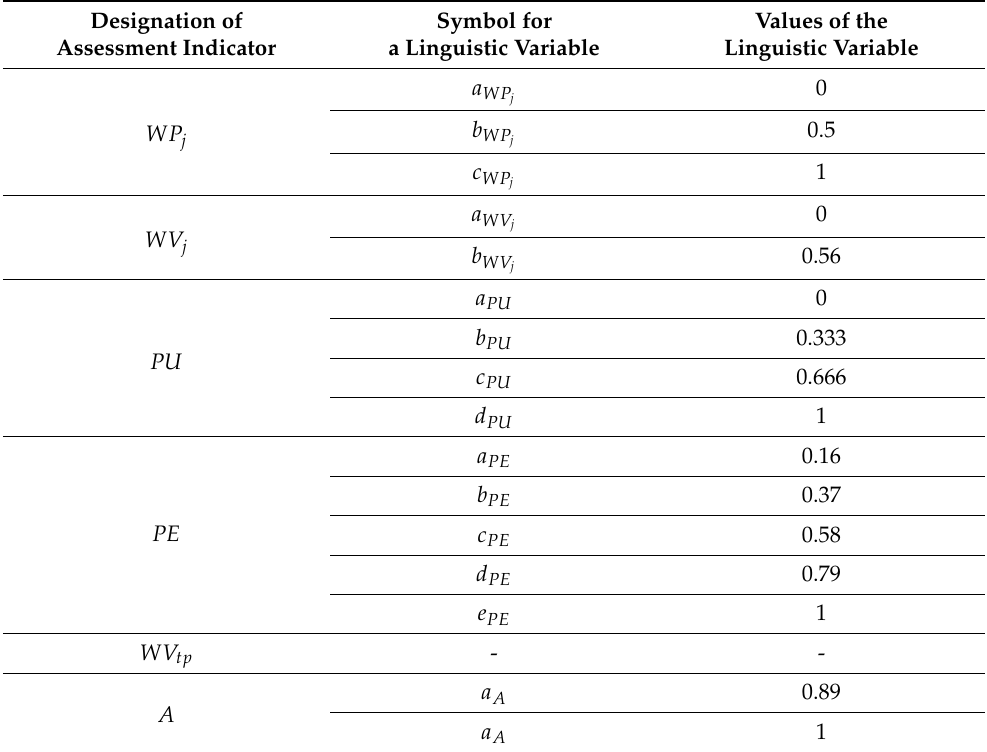
Table 3. Values of individual linguistic